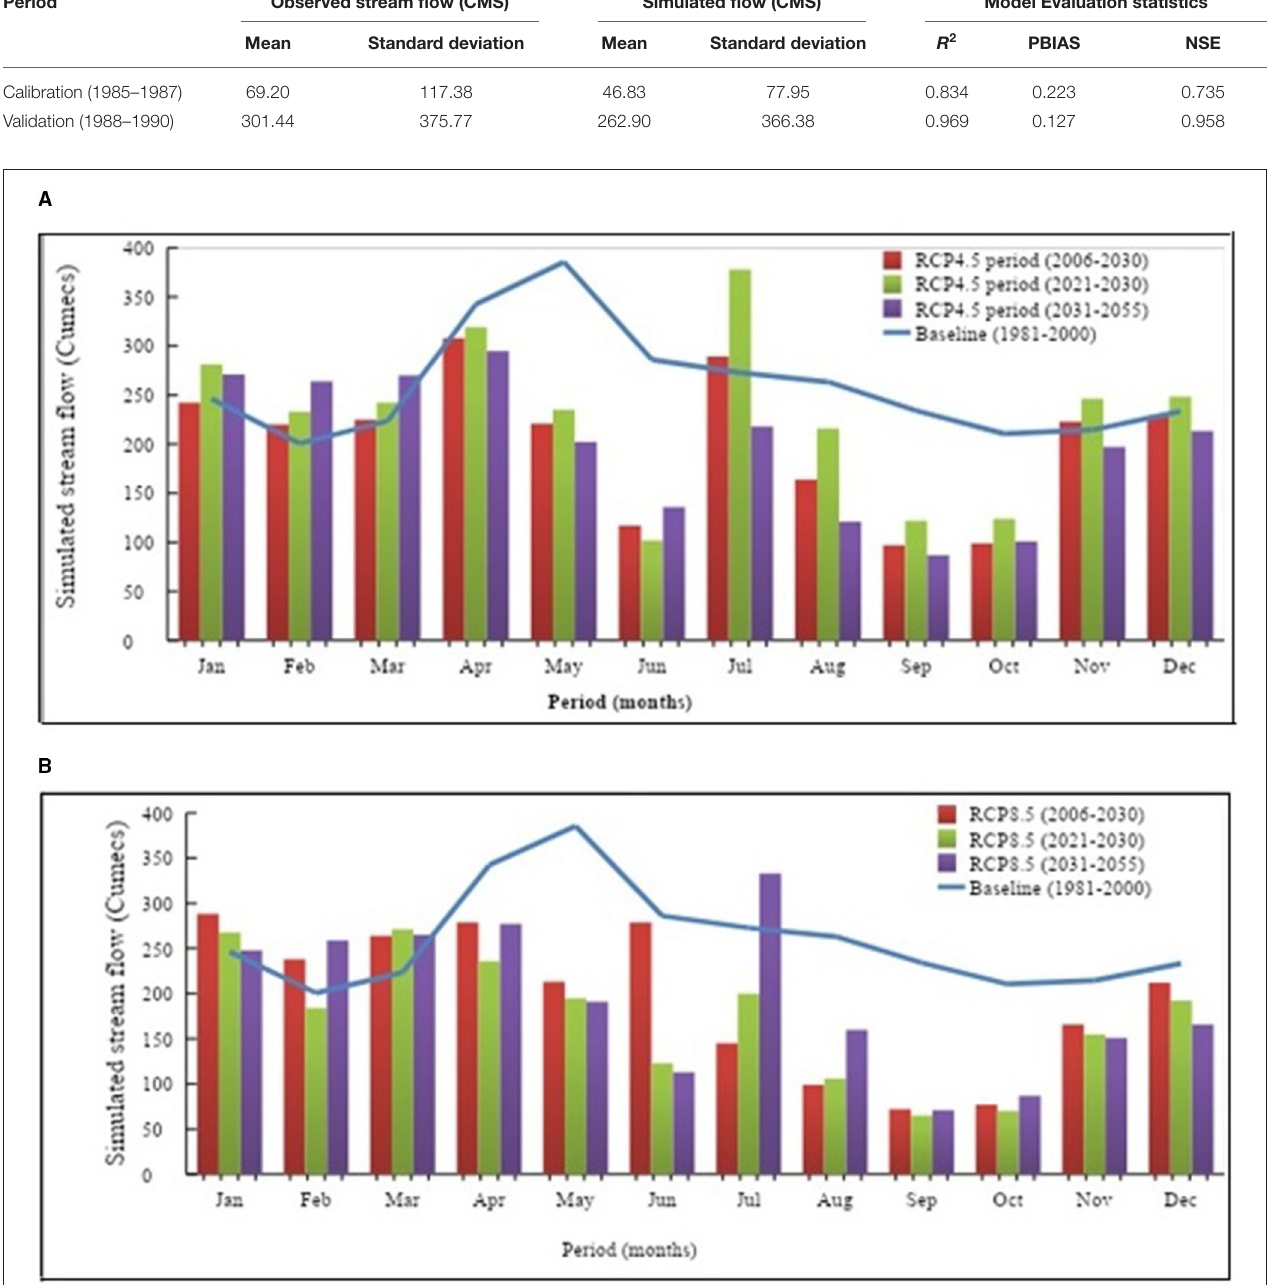
FIGURE 5 | (A) Simulated and baseline mean monthly stream flows for RCP4.5 for Ewaso Ng’iro at RGS2K01. (B) Simulated and baseline mean monthly stream flows for RCP8.5 for Ewaso Ng’iro at